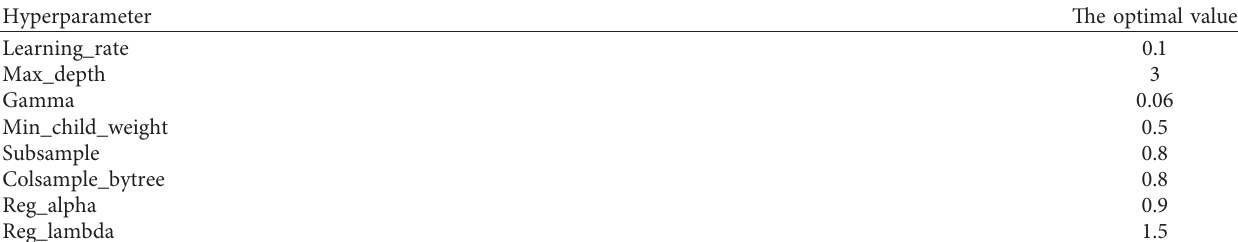
Table 7: Optimal parameter combination.